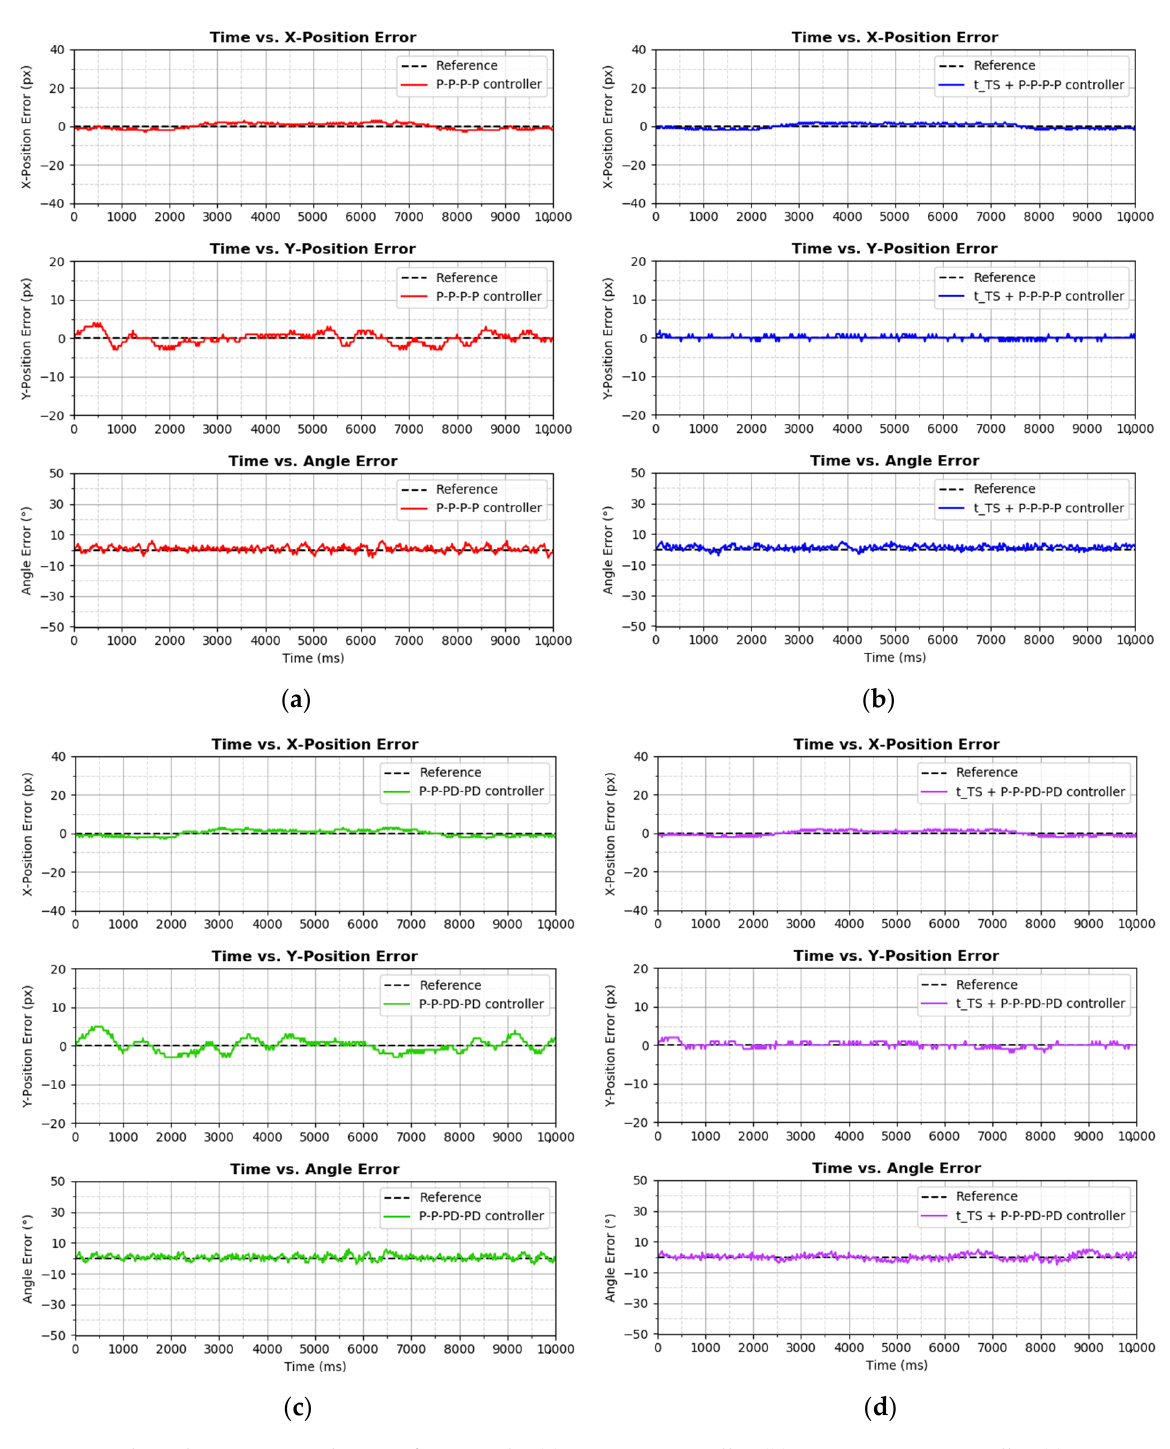
Figure 20. ∞ -shaped trajectory tracking performance by ( a ) P–P–P–P controller, ( b ) (cid:1872) (cid:2904)(cid:2903) + P–P–P–P controller, ( c ) P–P–PD–PD controller, and ( d ) (cid:1872) (cid:2904)(cid:2903) + P–P–PD–PD controller on graph.